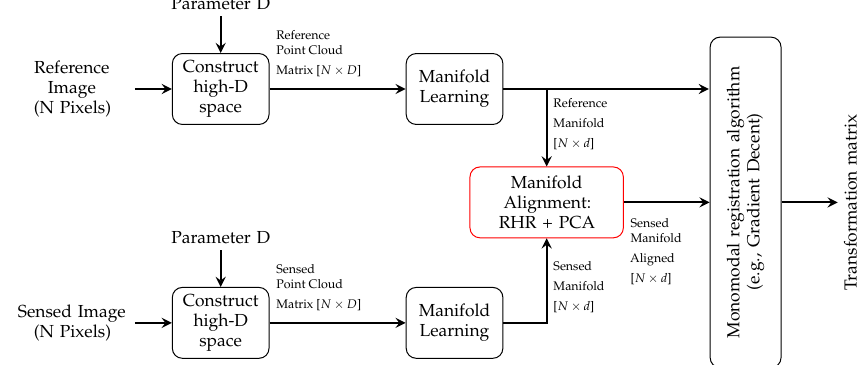
Figure 3. Pipeline of the proposed medical image registration using multi-modal to mono- modal